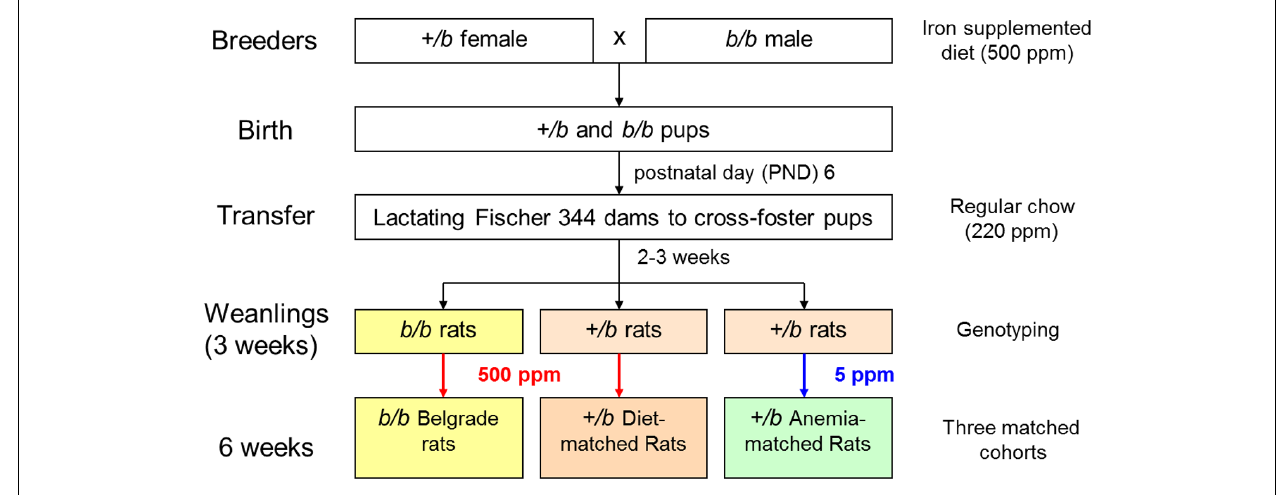
FIGURE 5 | Breeding and maintenance of the Belgrade